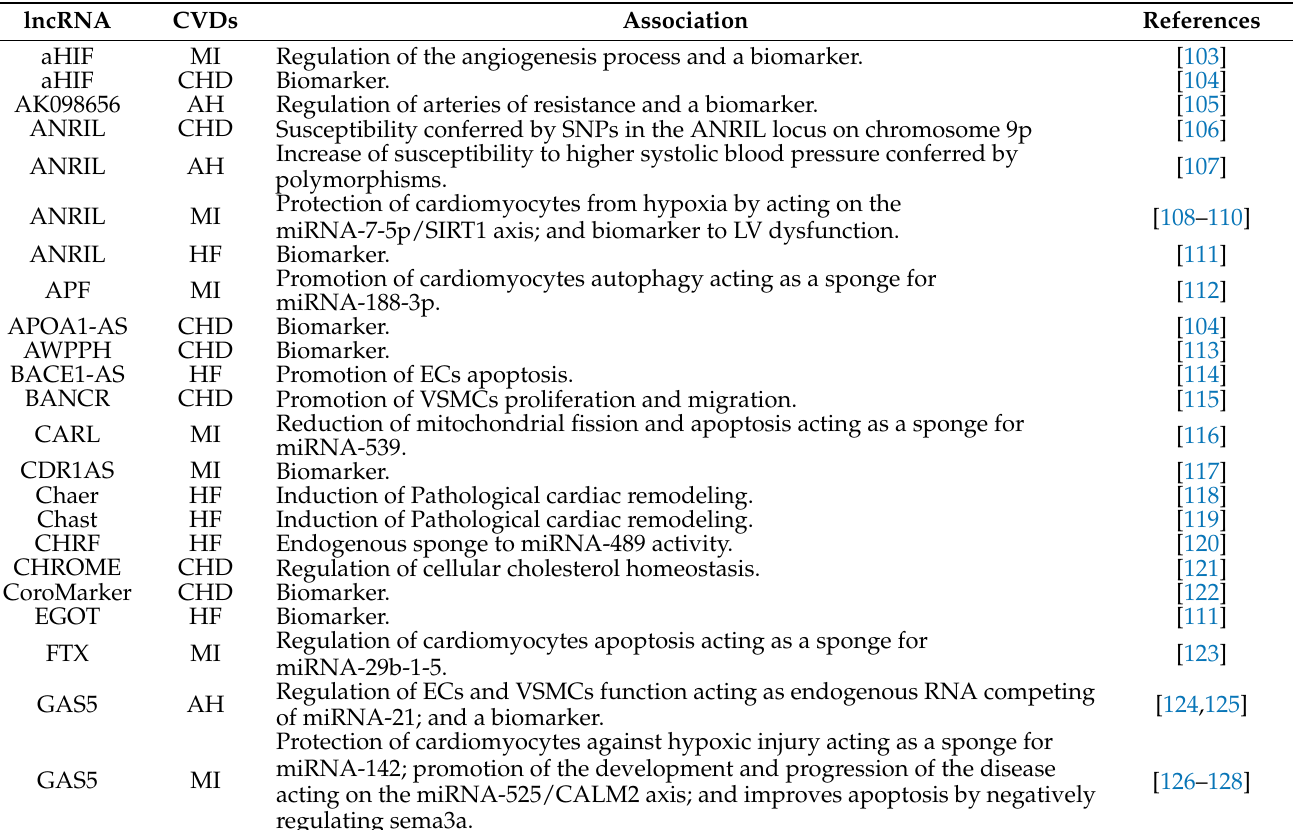
Table 1. List of lncRNAs involved in cardiovascular